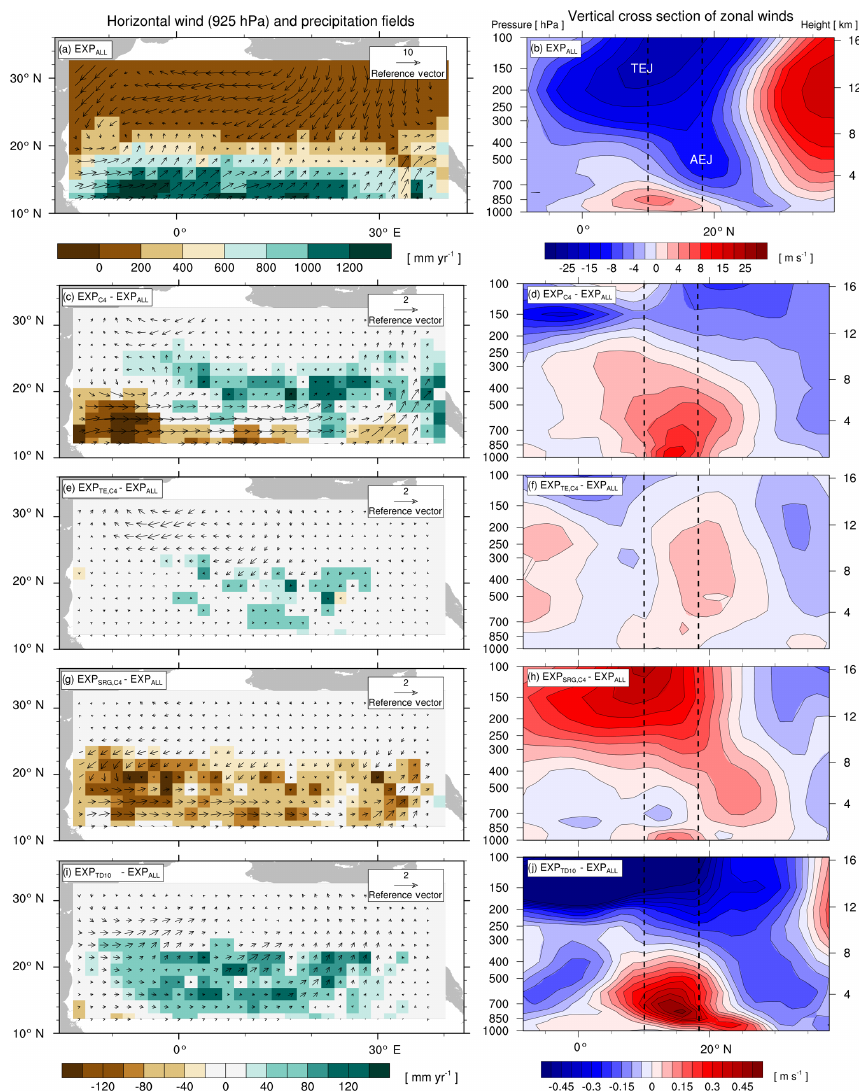
Figure 3. Effects of changes in plant functional diversity on precipitation P and large-scale atmospheric circulation patterns during the monsoon season (JJAS) under AHP conditions (8kyr). Left: horizontal low-level wind fields in the monsoon layer (925hPa) and P fields. Right: vertical cross sections of zonal winds (9.33 to 39.17 ◦ N, 10.31 ◦ W to 40.31 ◦ E). Dotted lines mark the core regions of mid-level African easterly jet (AEJ, 600hPa) and upper-level tropical easterly jet (TEJ, 150hPa) in EXP ALL . Panels (a, b) show the 100-year average for the experiment with the standard PFT set (EXP ALL ); the following panels illustrate differences in 100-year averages between EXP ALL (c, d) , EXP TE , C (e, f) , EXP SRG , C (g, h) , and EXP TD (i, j) and EXP C 10 4 4 4